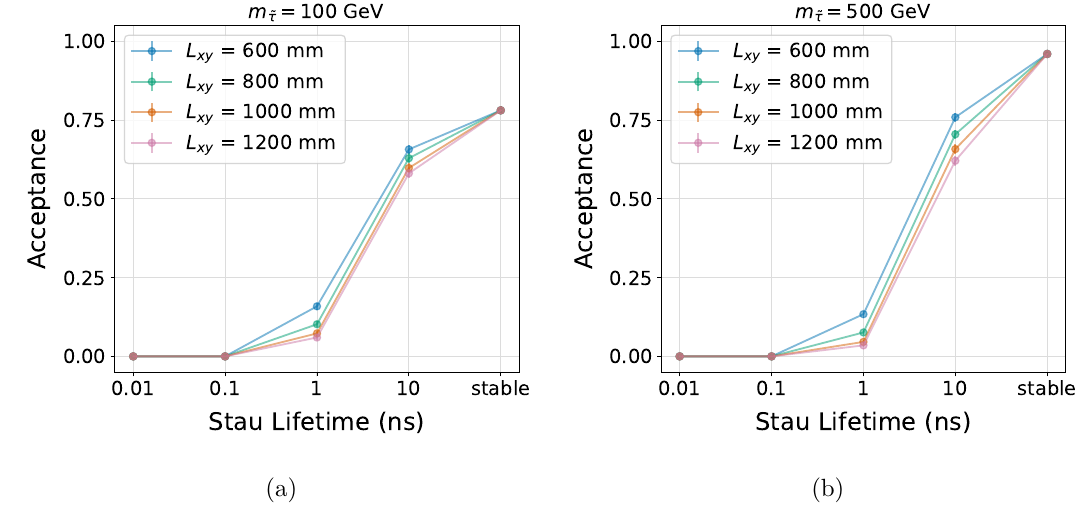
Figure 17. Stau event-level acceptance for a variety of minimum tracker L xy values. Acceptance is shown as a function of stau lifetime for staus with mass m The track-trigger covers | η | < 2 . 5